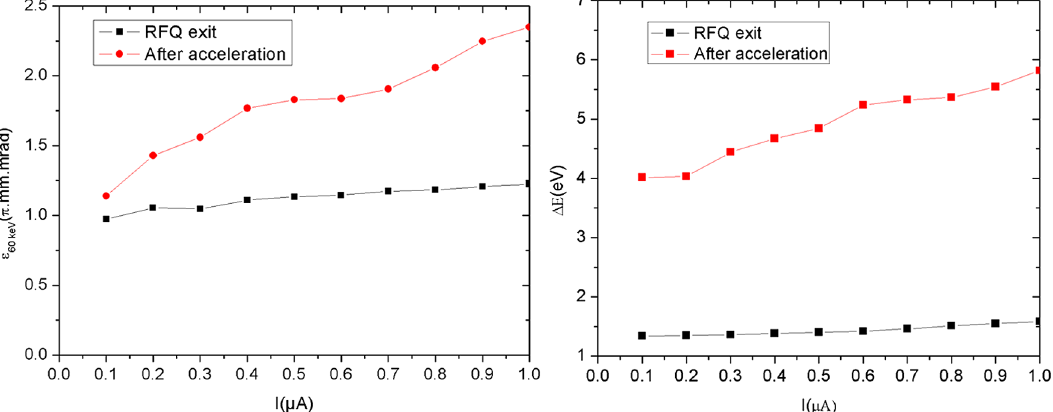
FIG. 2. Space charge effect on the beam quality: (right) simulated results of the beam current effect on the beam emittance; (left) longitudinal energy spread Δ E dependency to the beam current [17].